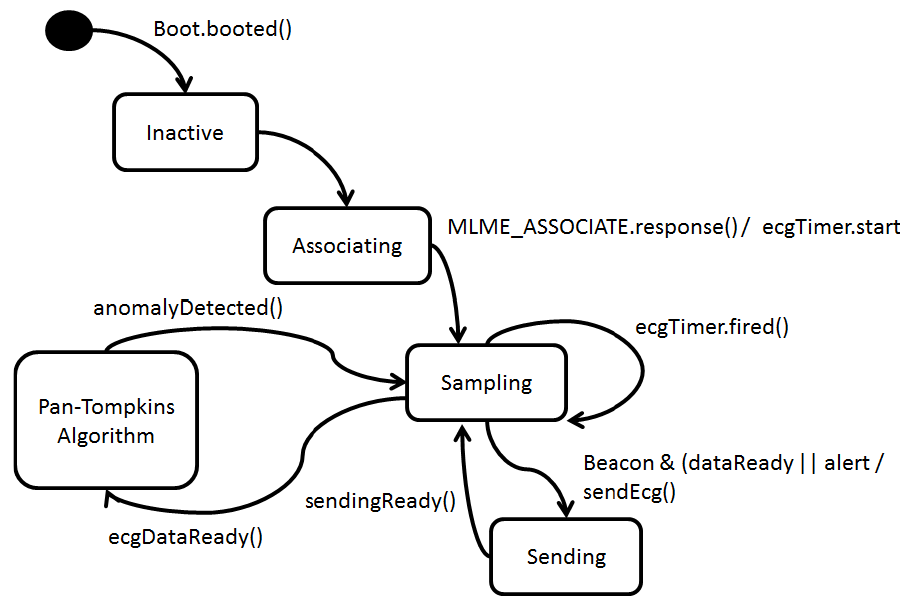
Figure 13. Network Device State